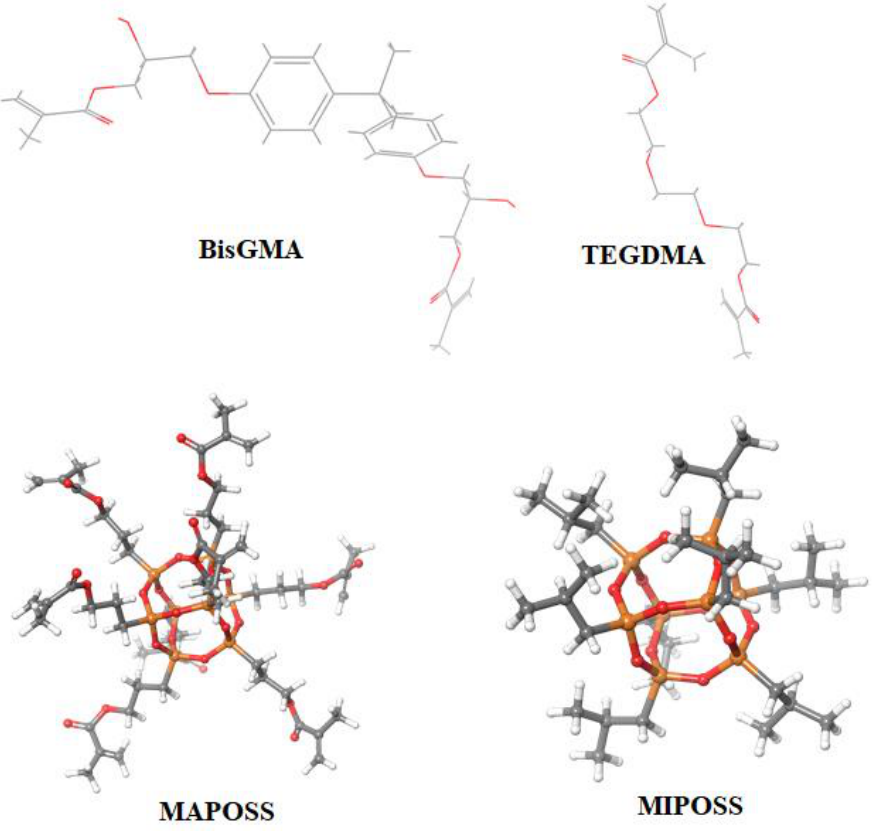
Figure 1. Chemical structures of BisGMA, TEGDMA, MAPOSS, and MIPOSS. Table 1. Composition and individual number of molecules of different composites.